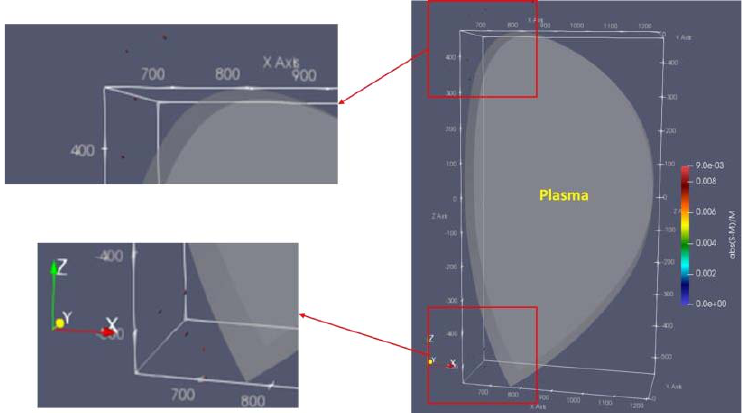
Figure 4. Map of neutron flux deviation |SuperMC-MCNP|/MCNP greater than